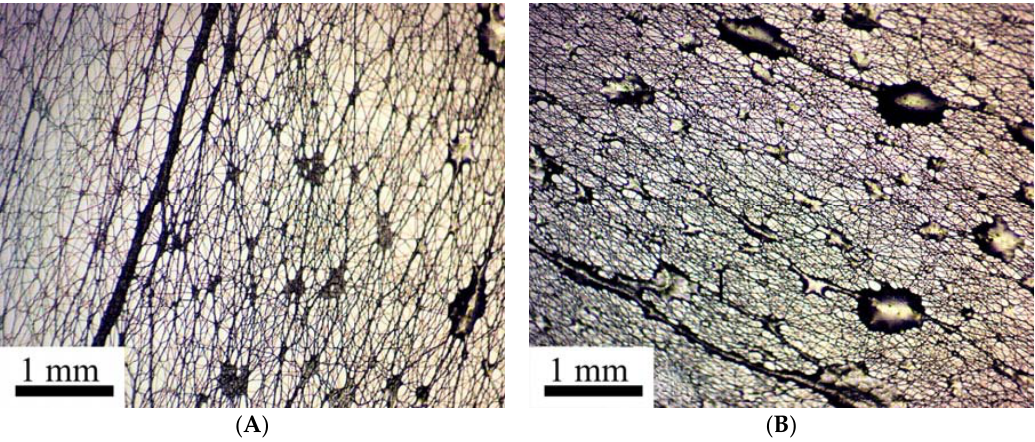
Figure 15. Photos of PAN—web in 5 ( a ) and 10 min ( b ) after electrospinning from DMSO solution. This means that depending on the phase state of a solution and a type of the solvent, both mechanisms (phase separation and solvent evaporation) may coexist [80].